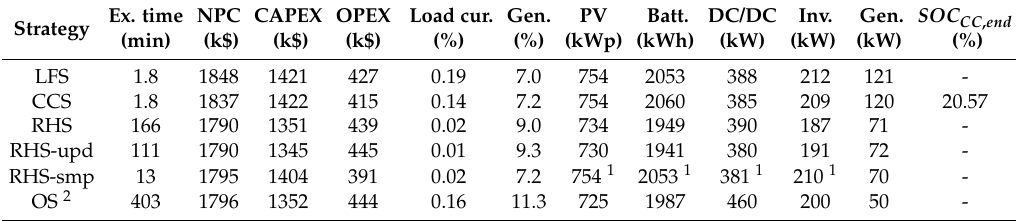
Table 2. Optimal design of the mini-grid with one-shot (OS) and different heuristic optimization methods (load-following (LFS), Cycle-Charging (CCS), Rolling-Horizon Strategies (RHS), RHS-smp, and RHS-upd).